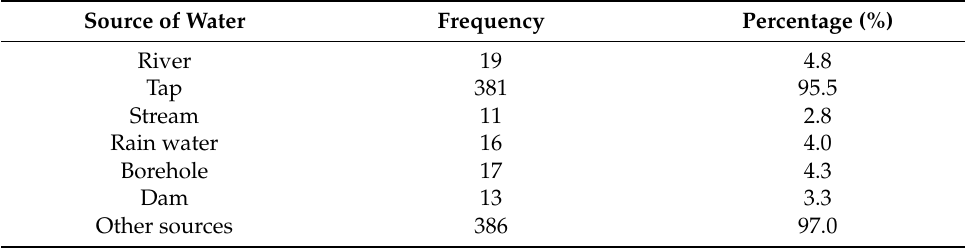
Table 4. Respondents’ sources of drinking